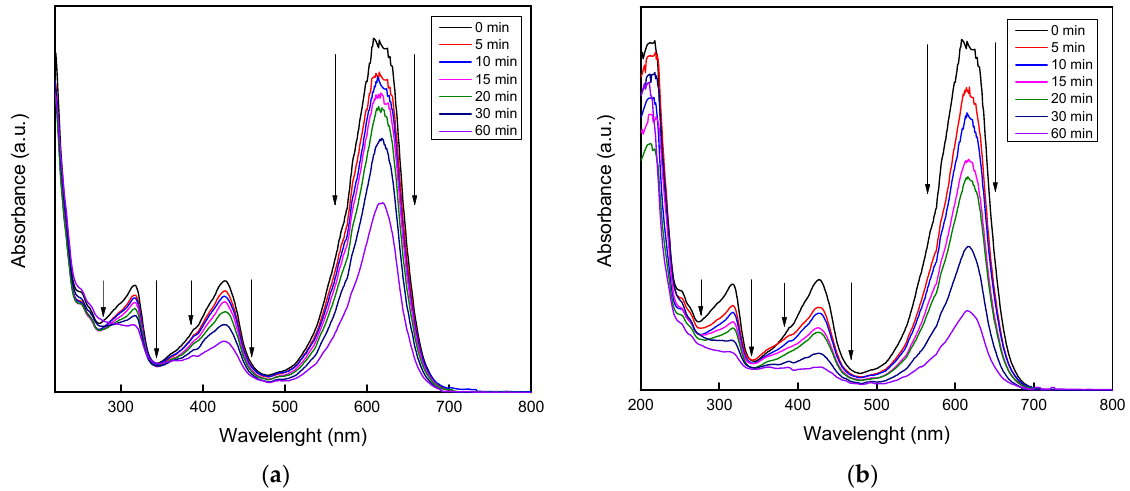
Figure 11. Absorbance spectra of MG dye using the Ag-TiO 2 photoanode through ( a ) EC and ( b ) PEC processes at different reaction times.